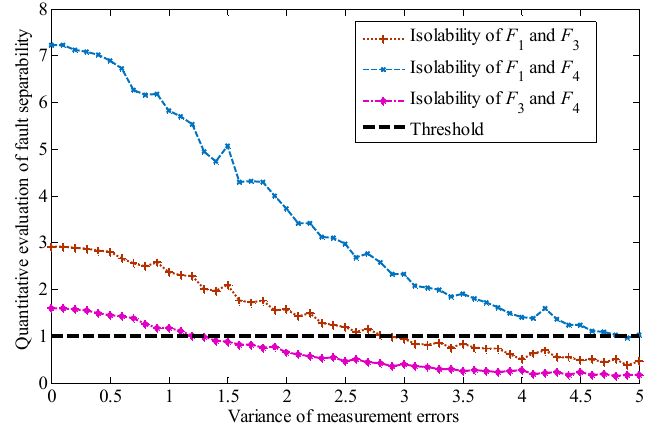
Figure 8. Quantitative evaluation of fault isolability under measurement errors.